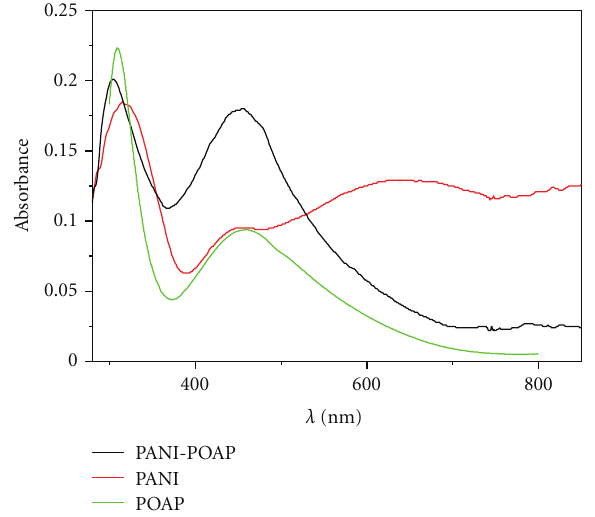
Figure 3: UV-Vis spectra of PANI; POAP and PANI-POAP films grown on an ITO electrode from 0.1M ANI; 0.001 M OAP; and 0.1M ANI + 0.001 M OAP solutions,